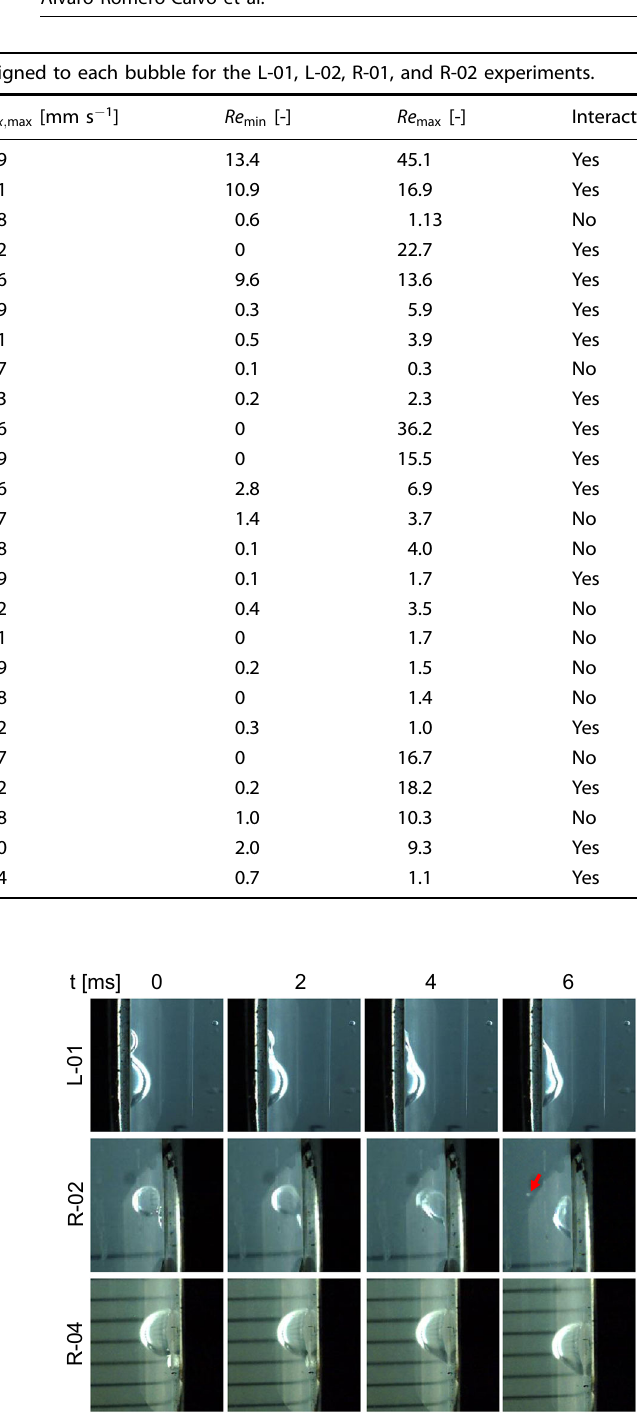
Fig. 4 Bubble coalescence events at the wall for the L-01, R-02, and R-04 experiments as a function of time. The red arrow indicates the ejection of a small gas bubble after bubble